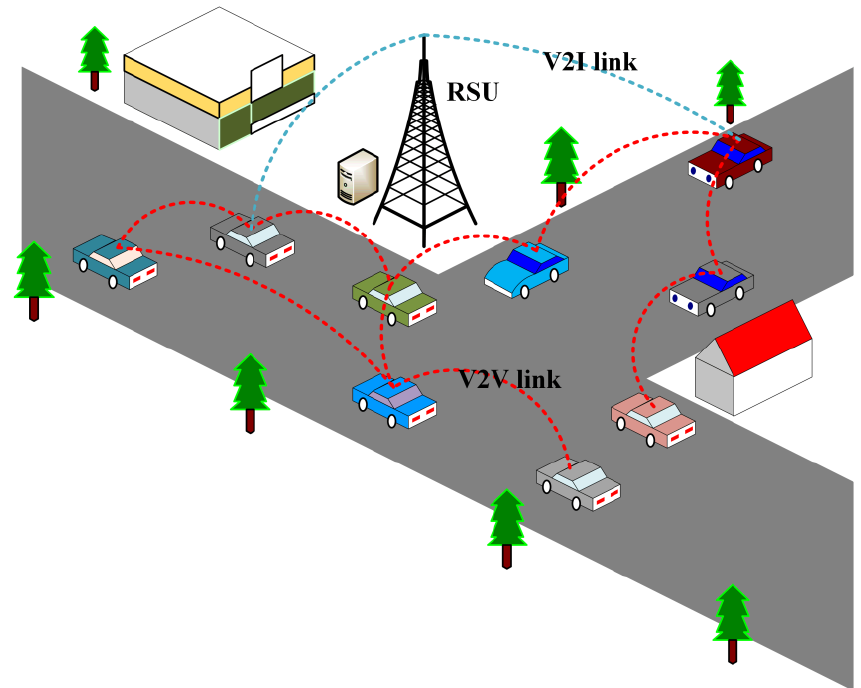
Figure 1. Illustration of cooperative perception. Vehicles can connect with other vehicles via V2V links and can connect with RSUs via V2I links. Detected environmental information can be transmitted among all participants.